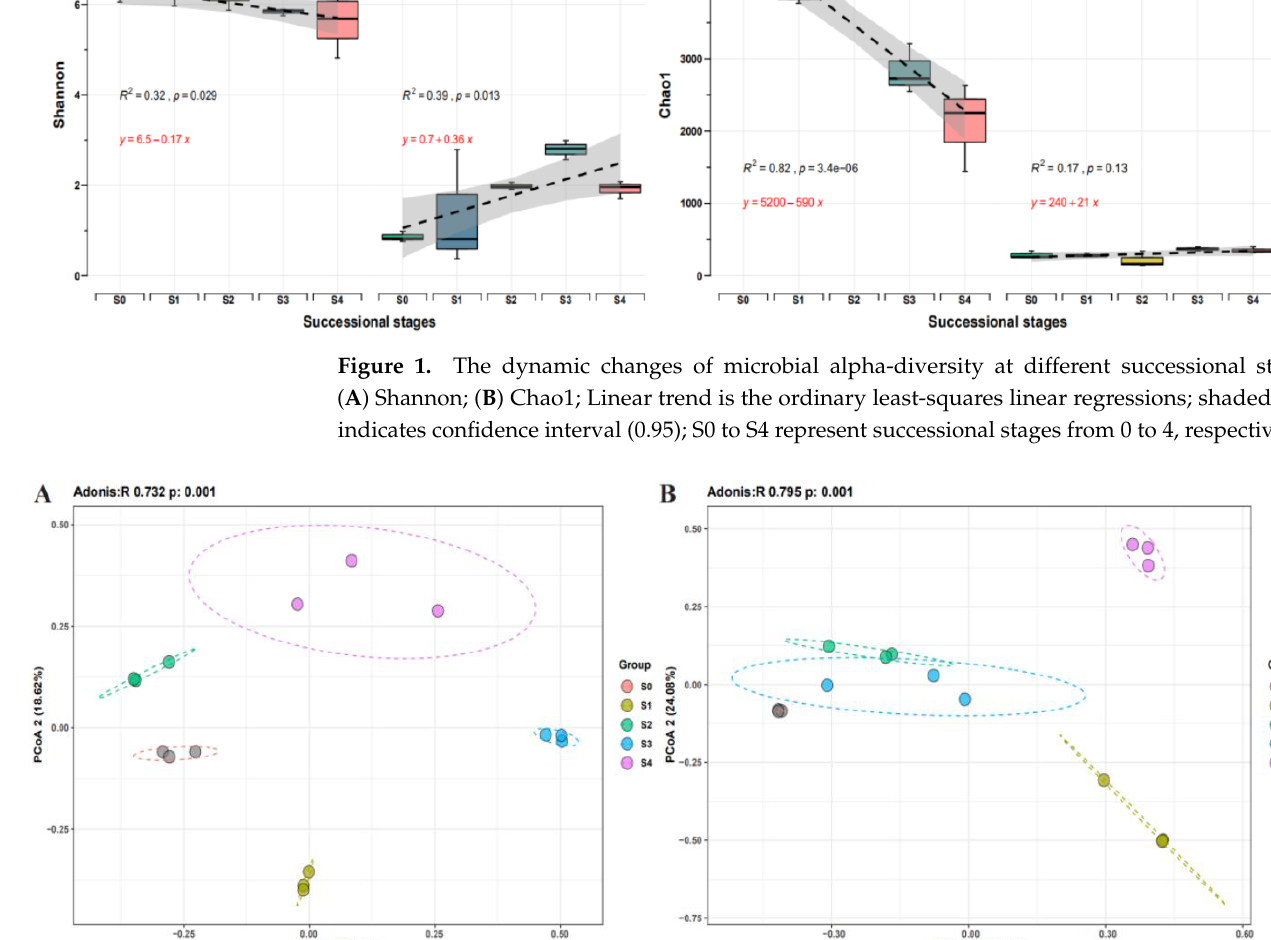
Figure 1. The dynamic changes of microbial alpha-diversity at different successional stages. ( A ) Shannon; ( B ) Chao1; Linear trend is the ordinary least-squares linear regressions; shaded area indi- cates confidence interval (0.95); S0 to S4 represent successional stages from 0 to 4, respectively.